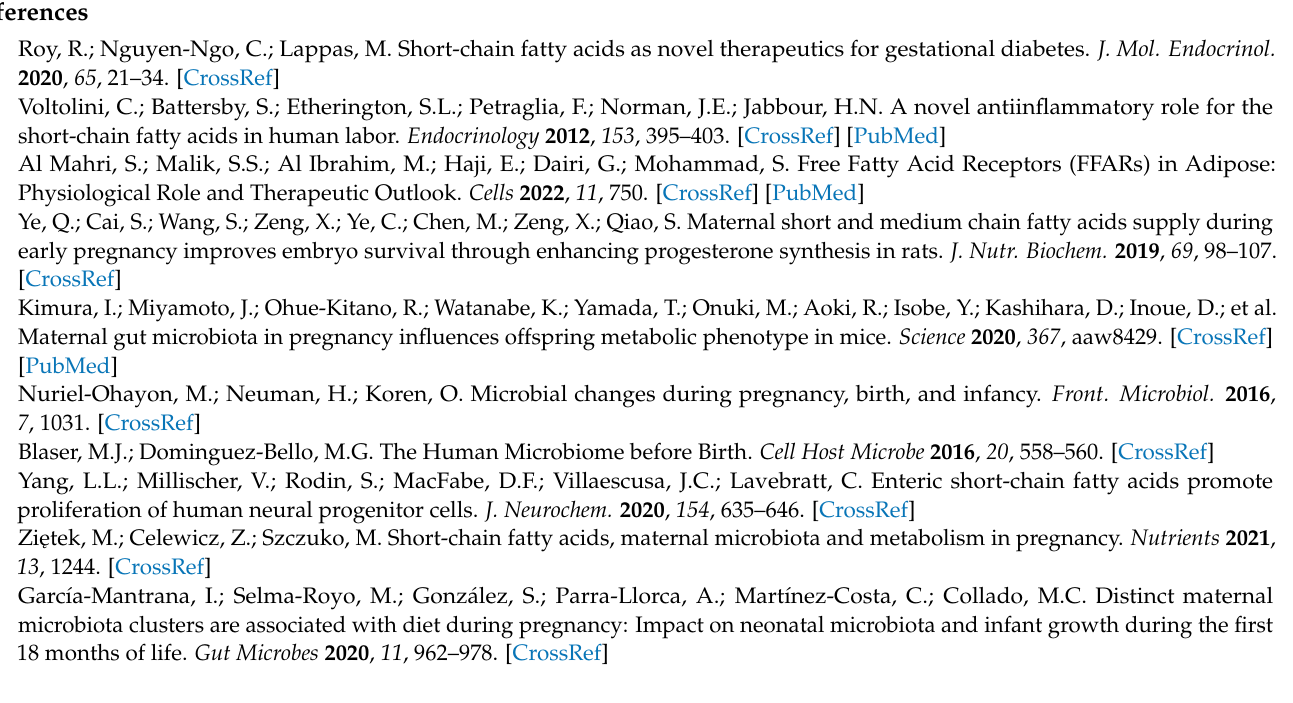
Table S2: Multivariate- adjusted linear regression of potential maternal factors related to maternal serum short chain fatty acids composition in the third trimester of